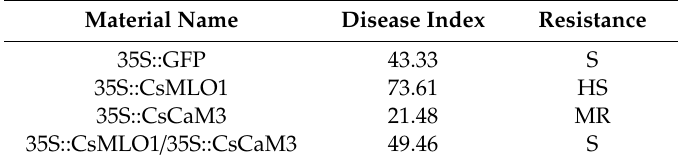
Table 1. Disease index of di ff erent cucumber cotyledons to C. cassiicola .